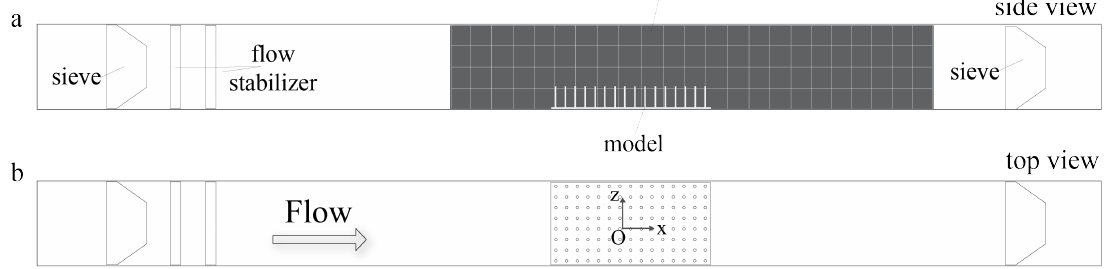
Experimental set up of submerged macrophyte models in the flow tank: ( a ) the view of flow tank setup from side; and ( b ) the view of flow tank from above. Flow tank is 100 cm (L) × 8 cm (W) × 8 cm